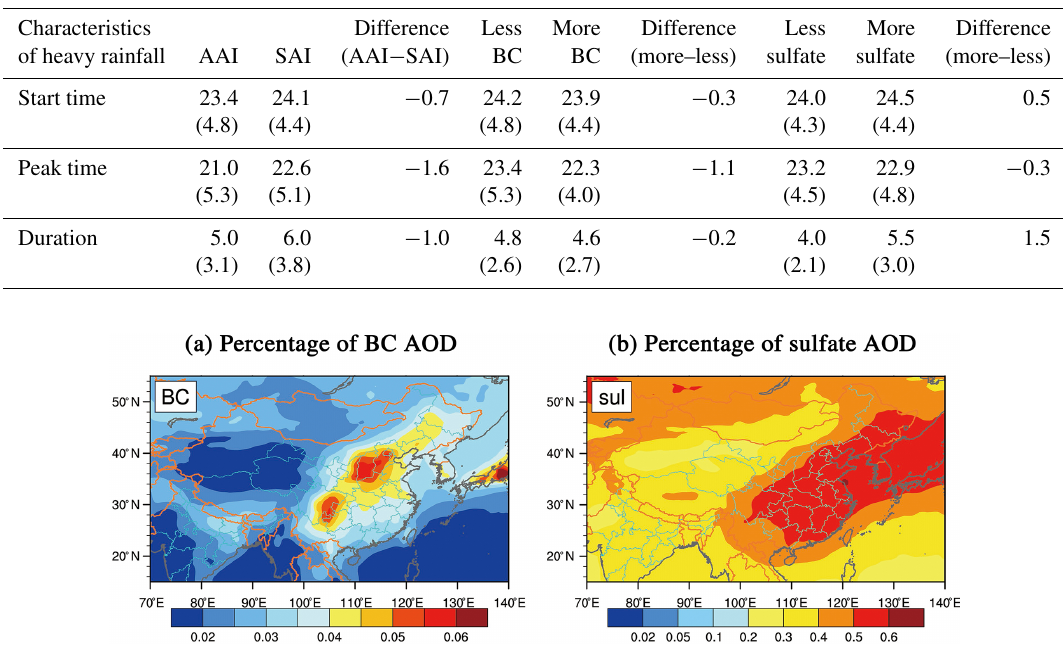
Table 3. The mean values of start time (units: LST), peak time (units: LST) and duration (units: hours) of heavy rainfall, respectively, on the conditions with more absorbing aerosols (AAI more than the 75th percentile, from OMI), more scattering aerosols (SAI more than the 75th percentile, from OMI), less or more BC (AOD of BC less than the 25th or more than the 75th percentile, from MACC), less or more sulfate (AOD of sulfate less than the 25th or more than the 75th percentile, from MACC), and their differences. Numbers in the brackets stand for the standard deviations on the means. All differences have passed the significance test of 95%.